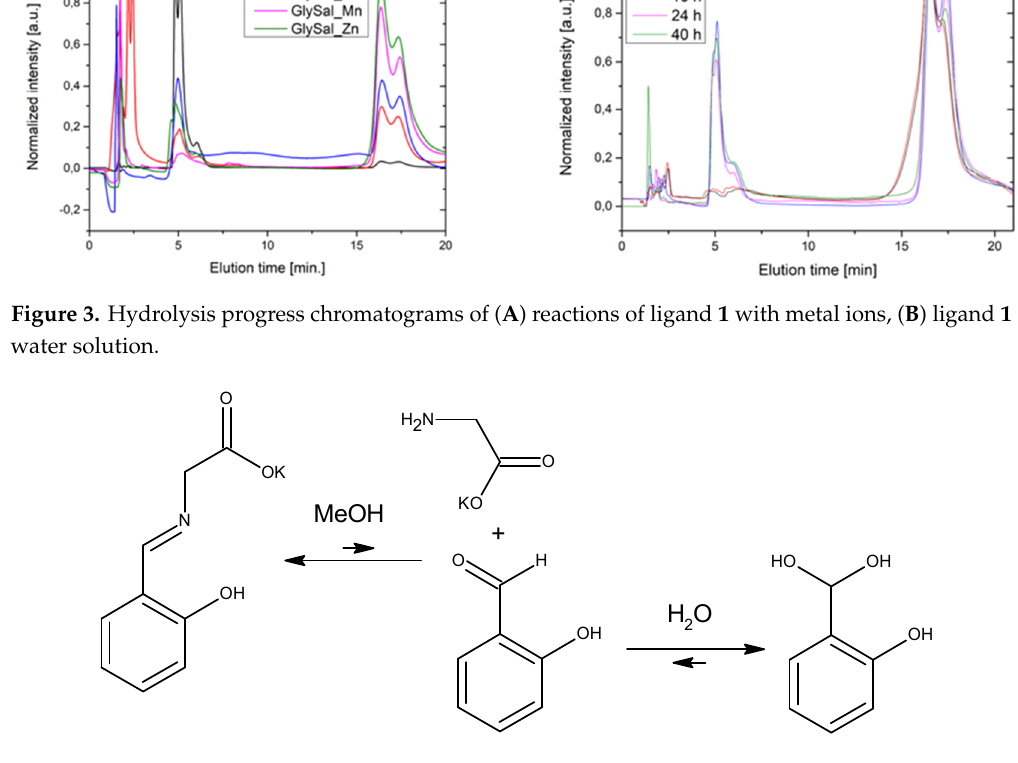
Figure 3. Hydrolysis progress chromatograms of ( A ) reactions of ligand 1 with metal ions, ( B ) ligand 1 water